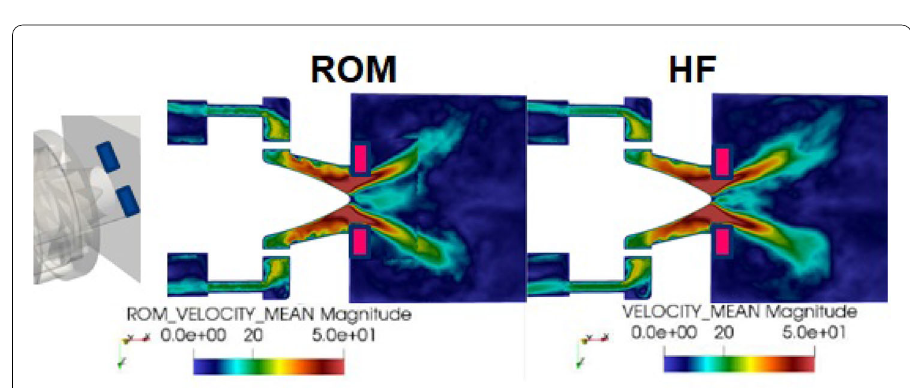
Fig. 36 The new geometrical mean velocity field for configuration